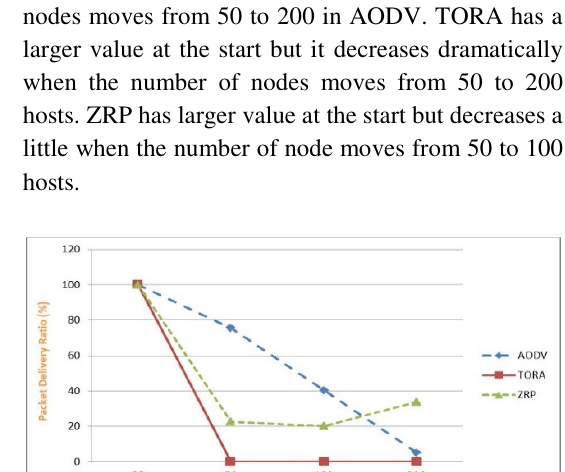
Fig. 3: Packet Delivery Ratio vs. Number of